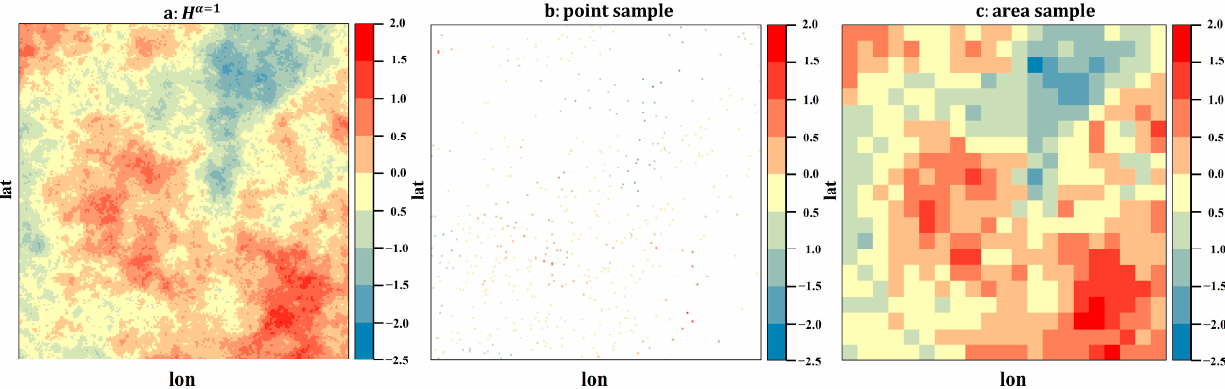
Figure 4. Real process and sampling data in the case of (cid:2009) = 1 .